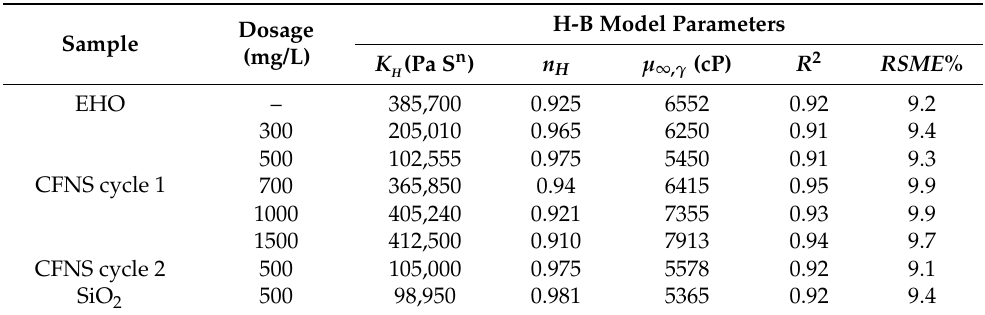
Table 3. Herschel–Bulkley model parameters for mixtures between EHO and different nanoparticles at 25 ◦